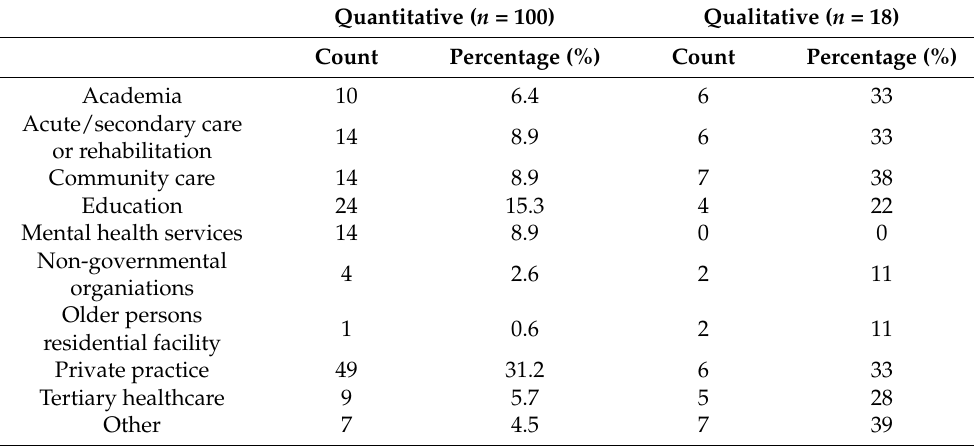
Table 2. Primary area of